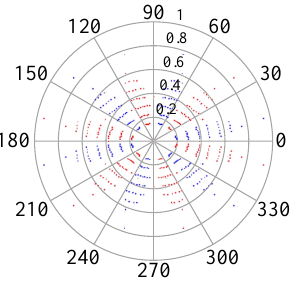
Figure 6. SDP image of power cable PD signals.